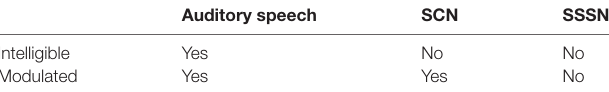
TABLE 2 | Intelligibility and modulation status of each auditory stimulation